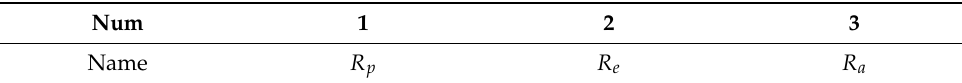
Table 7. Component definition.